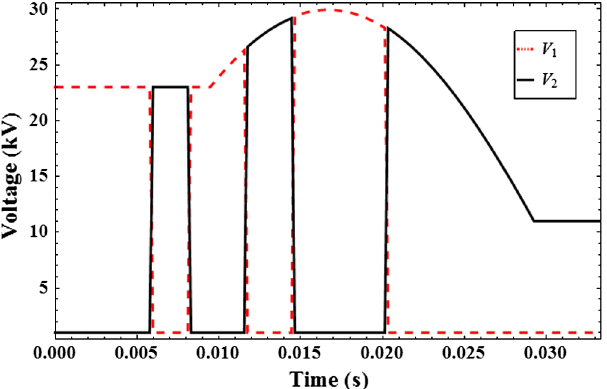
FIG. 5. Output voltage for each cavity system is depicted for a test ratcheting sequence. A ramping time of 100 μ s is chosen for the transition periods, and total voltages are calculated to meet ≤ 33 °. A minimum voltage of 1 kV is assumed the constraint ϕ s in order to allow rf tuning and phase synchronization for the “ offline ”